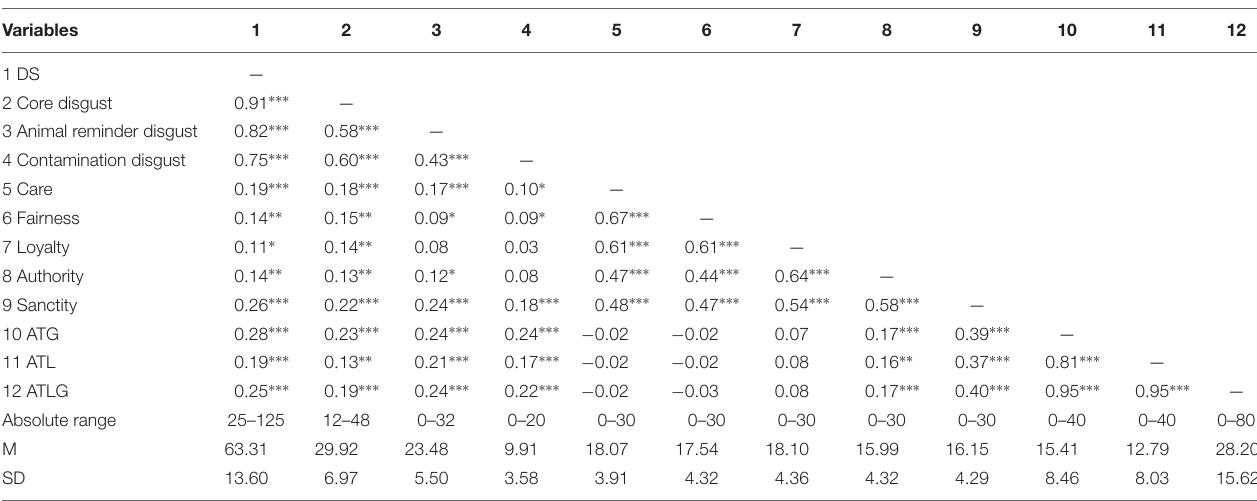
TABLE 1 | Descriptive statistics and partial correlations among variables.